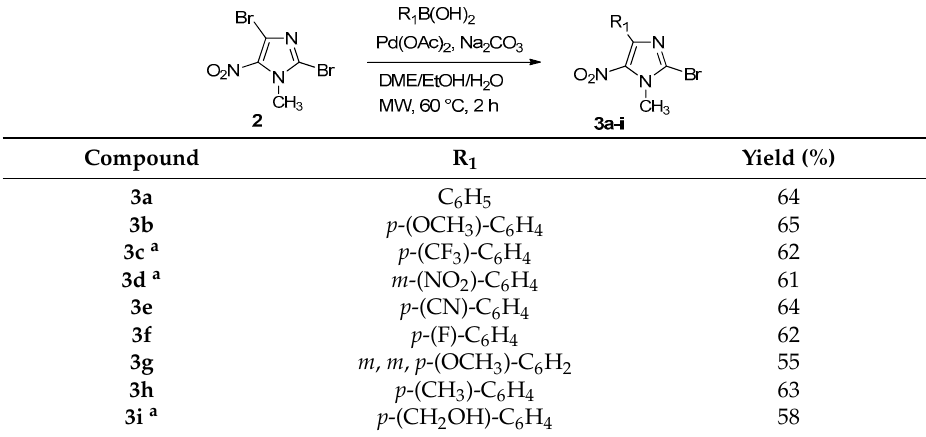
Table 2. Scope of the regioselective Suzuki-Miyaura reaction.